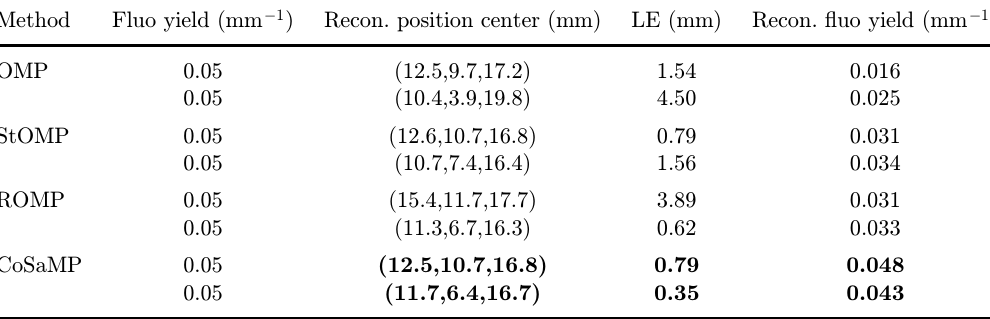
Table 3. Reconstructed results of double targets with same °uorescence